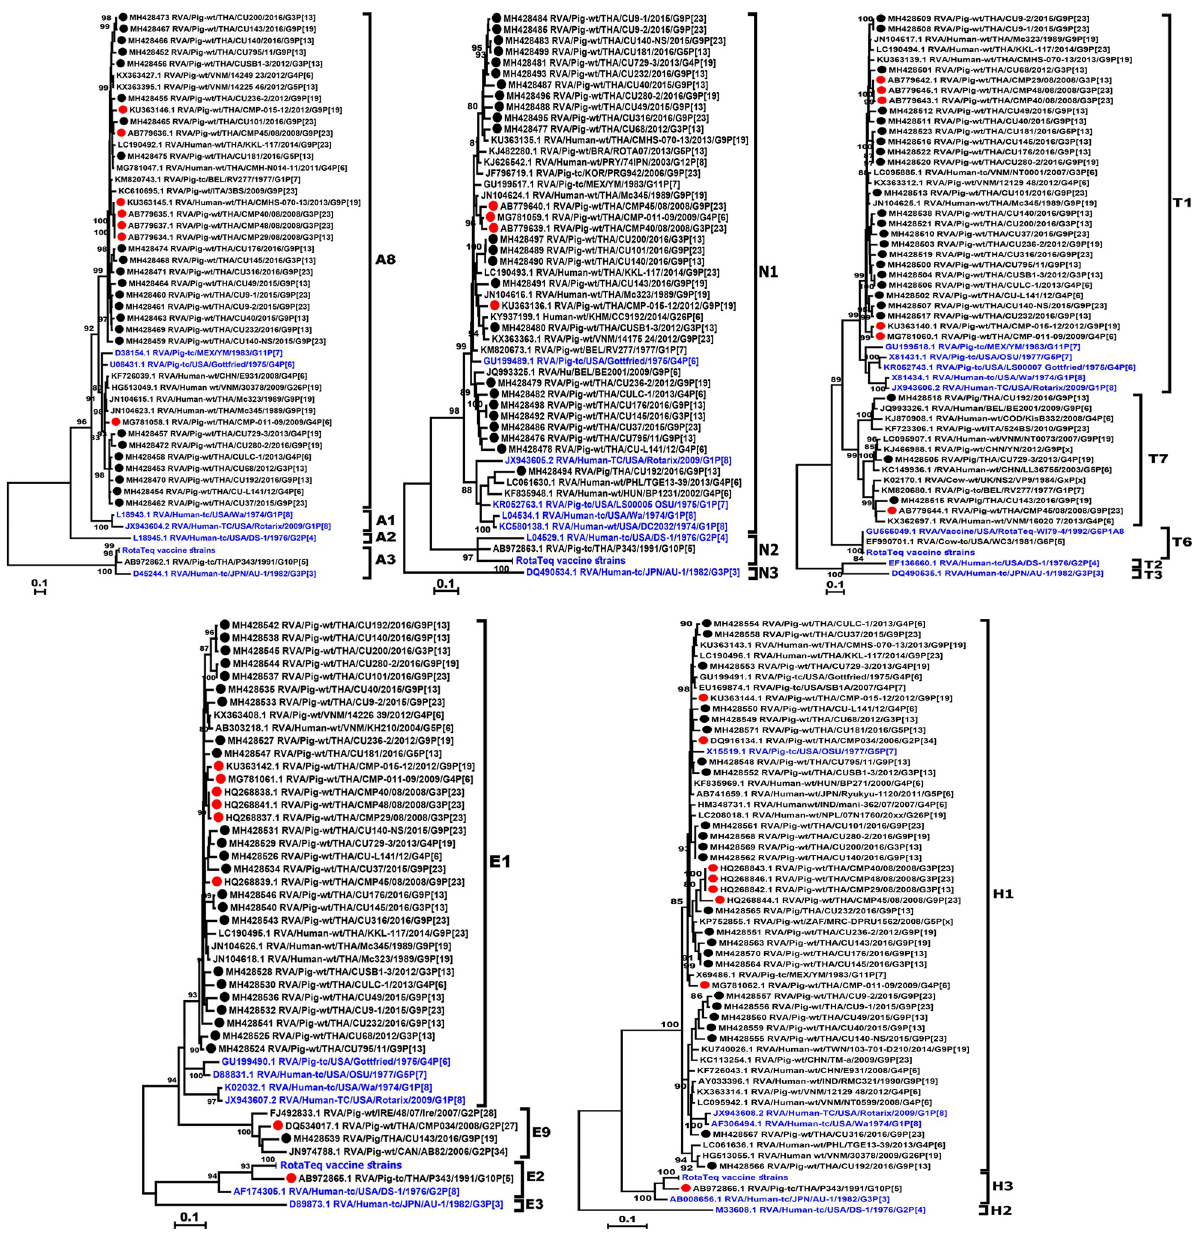
Fig 5. Phylogenetic analysis of the RVA non-structural genes. The nucleotide sequences of the Thai strains (dotted) were compared to those of previous Thai porcine RVA strains (red dotted), the RVA reference and vaccine strains (blue).